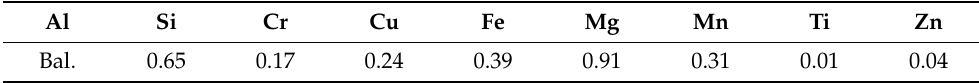
Table 2. The chemical composition of AA6061